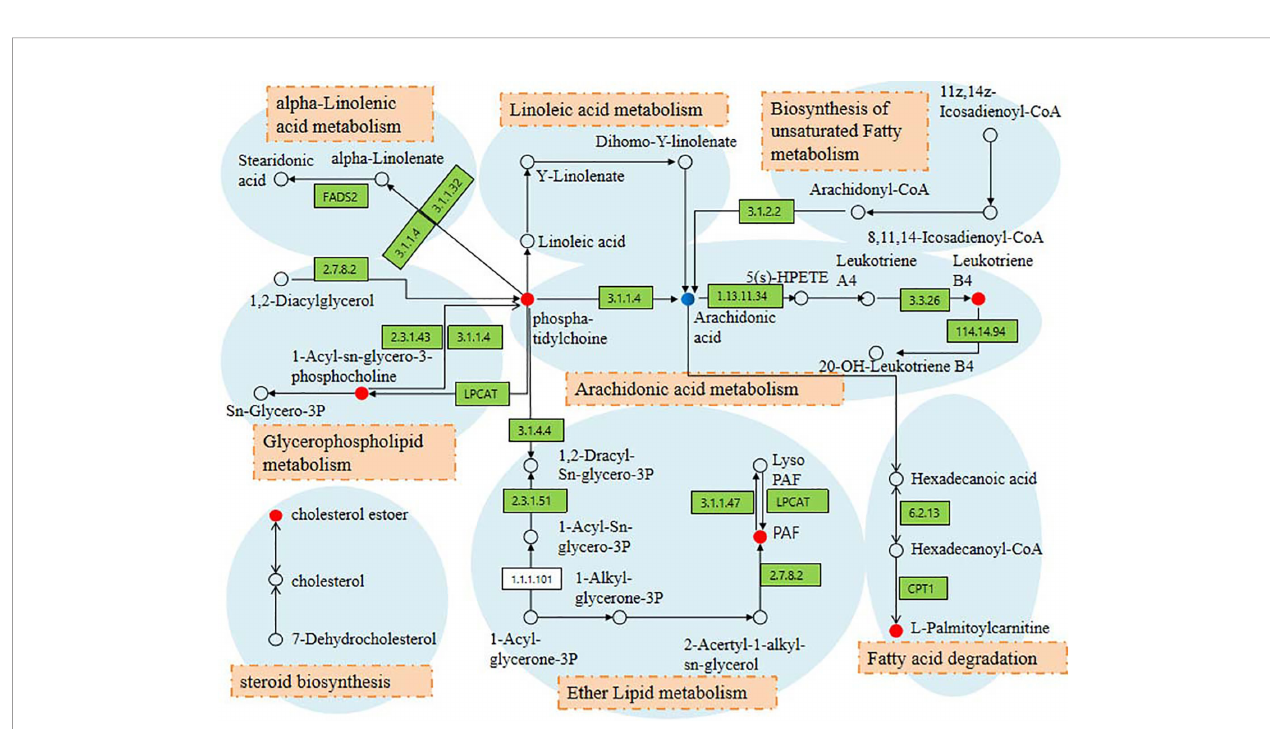
FIGURE 5 | Correlation networks of the potential biomarkers and the relevant metabolic pathways. Red and blue dots indicate potential biomarker organisms found in this study. Red: the content in the model group is higher than the control group; blue: the content in the model group is lower than the control group. Orange fi lled boxes indicate related metabolic